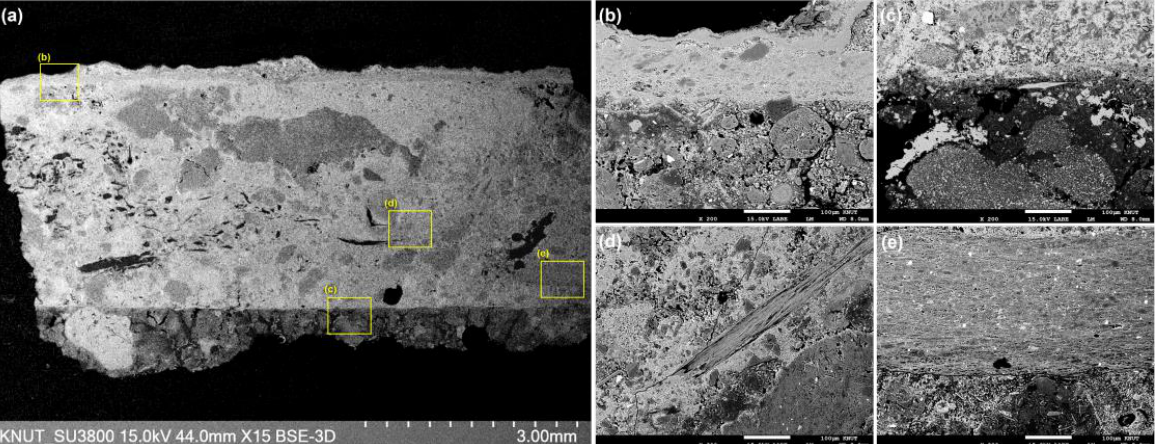
Figure 11. Result of Energy Dispersive Spectroscopy (EDS) of a part of mural sample. ( a ) Earthen layer. ( b ) Lime layer.